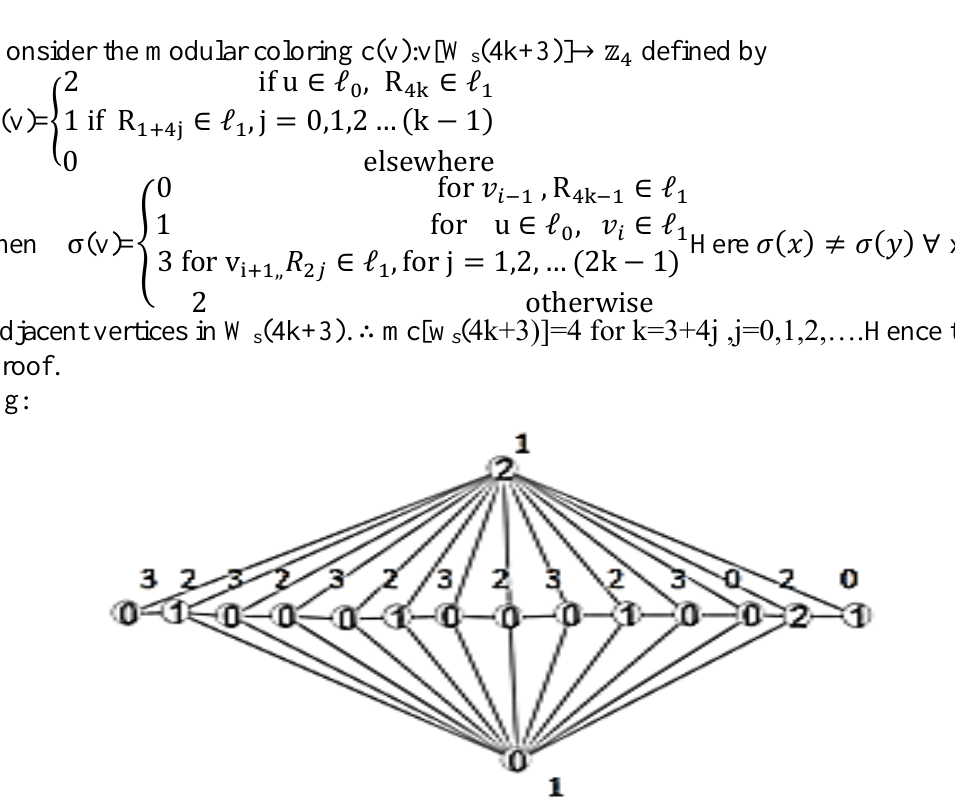
Figure 3 . Switching with modular coloring in